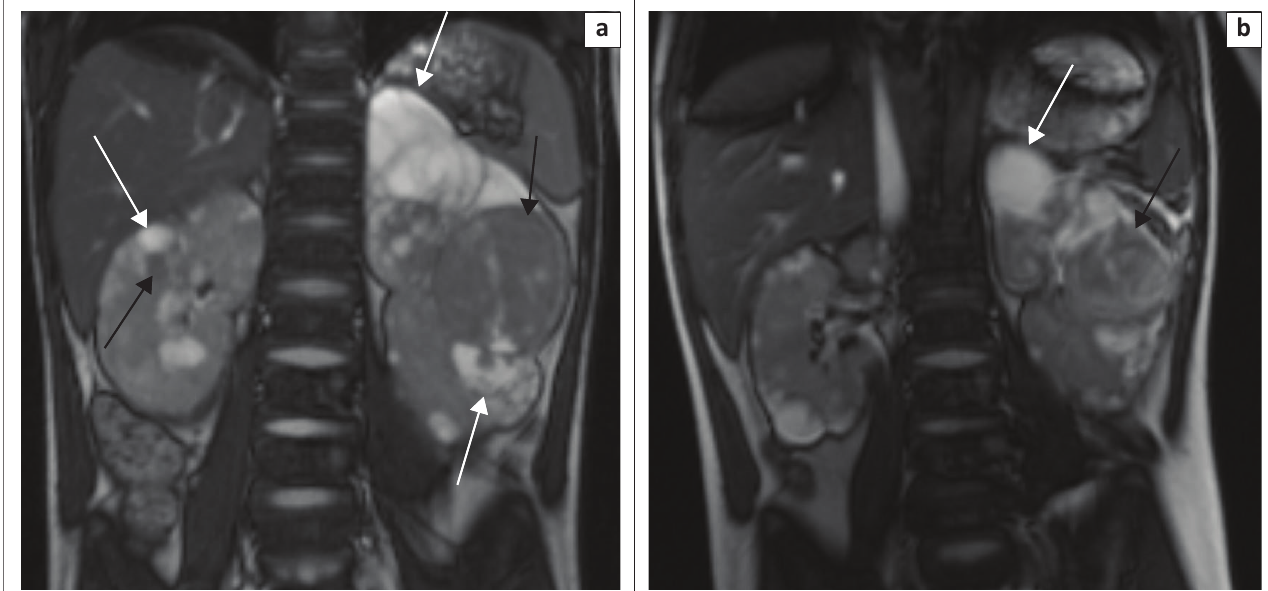
FIGURE 3: (a) Prior to treatment. T2-weighted coronal. Enlarged left kidney with multiple bilateral hyperintense (white arrows) and more hypointense masses (black arrows). (b) T2-weighted TRUFI coronal post-sirolimus and radiofrequency ablation of the left midpole renal cell carcinoma, with size reduction of left upper pole (white arrow) and midpole renal cell carcinoma ( black